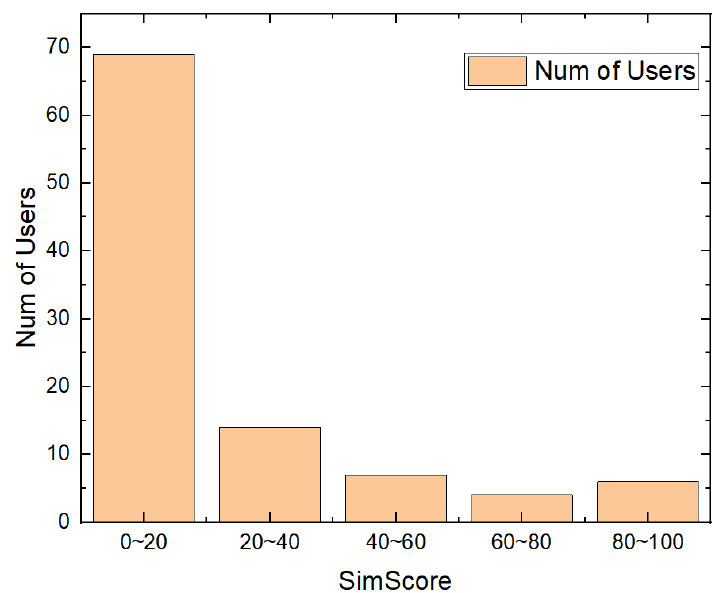
Figure 5. Accuracy of classifying each user’s political stance using Seq2Seq.